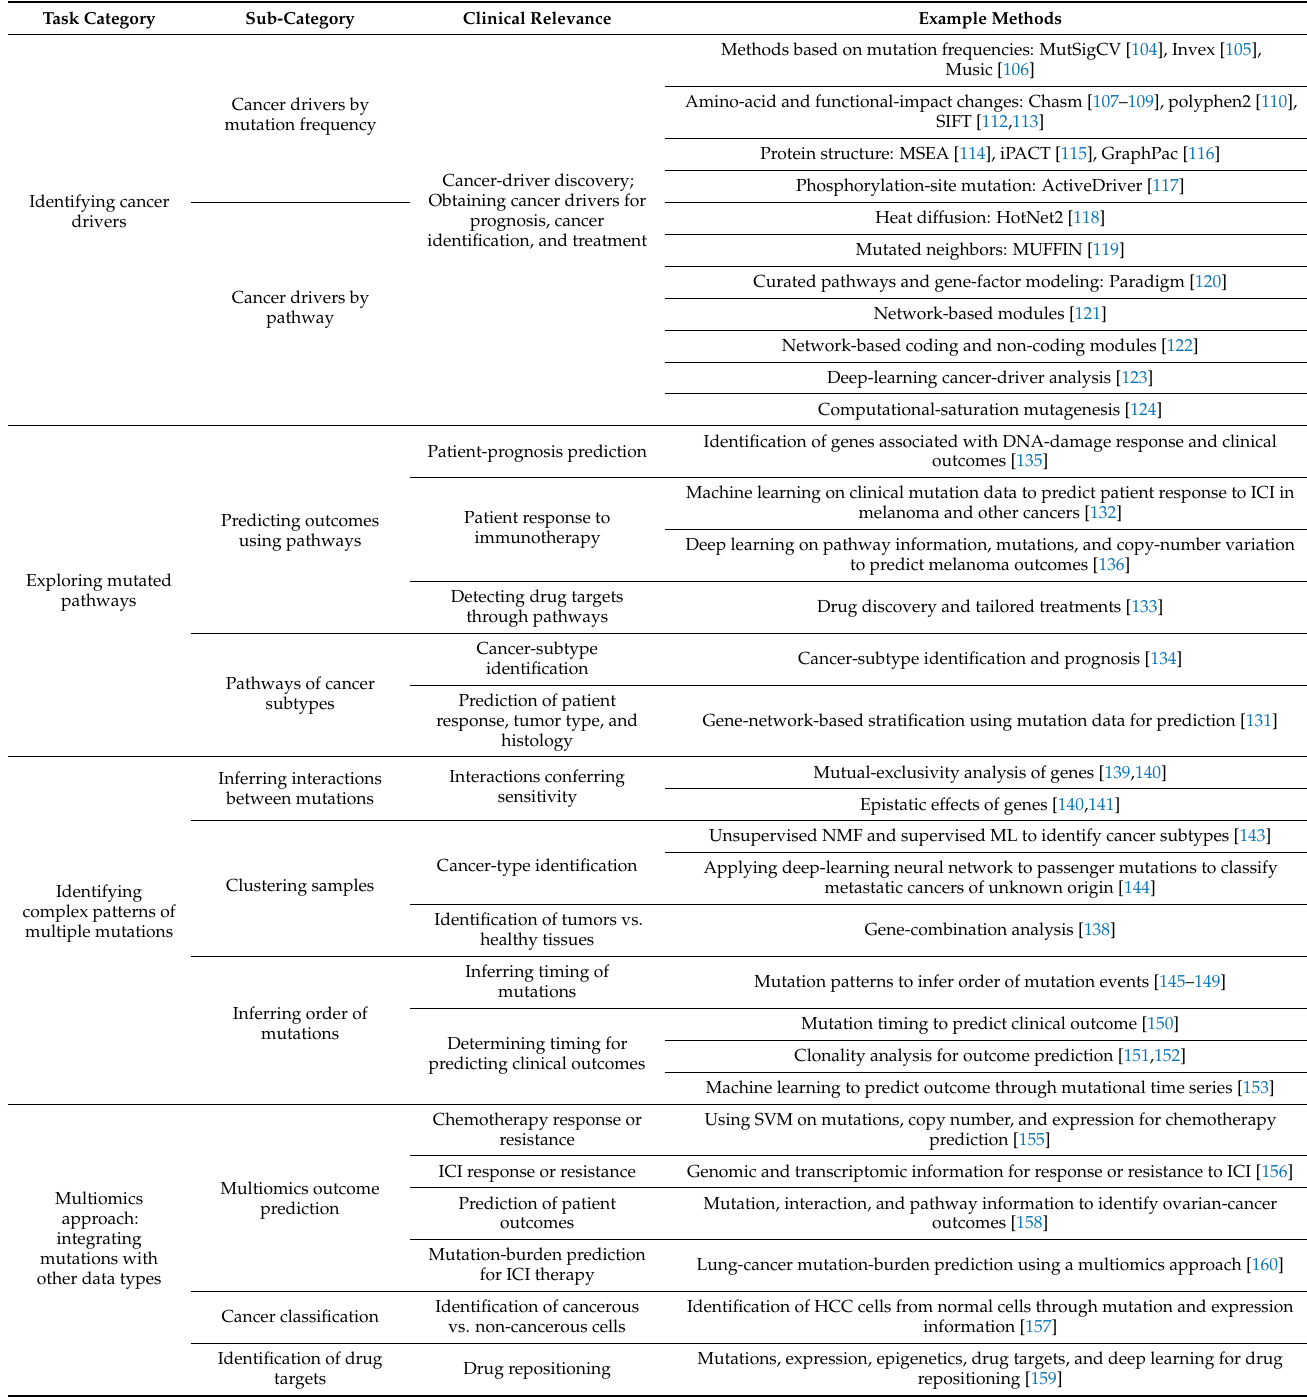
Table 2. Methods inferring clinically relevant mutation patterns beyond mutation